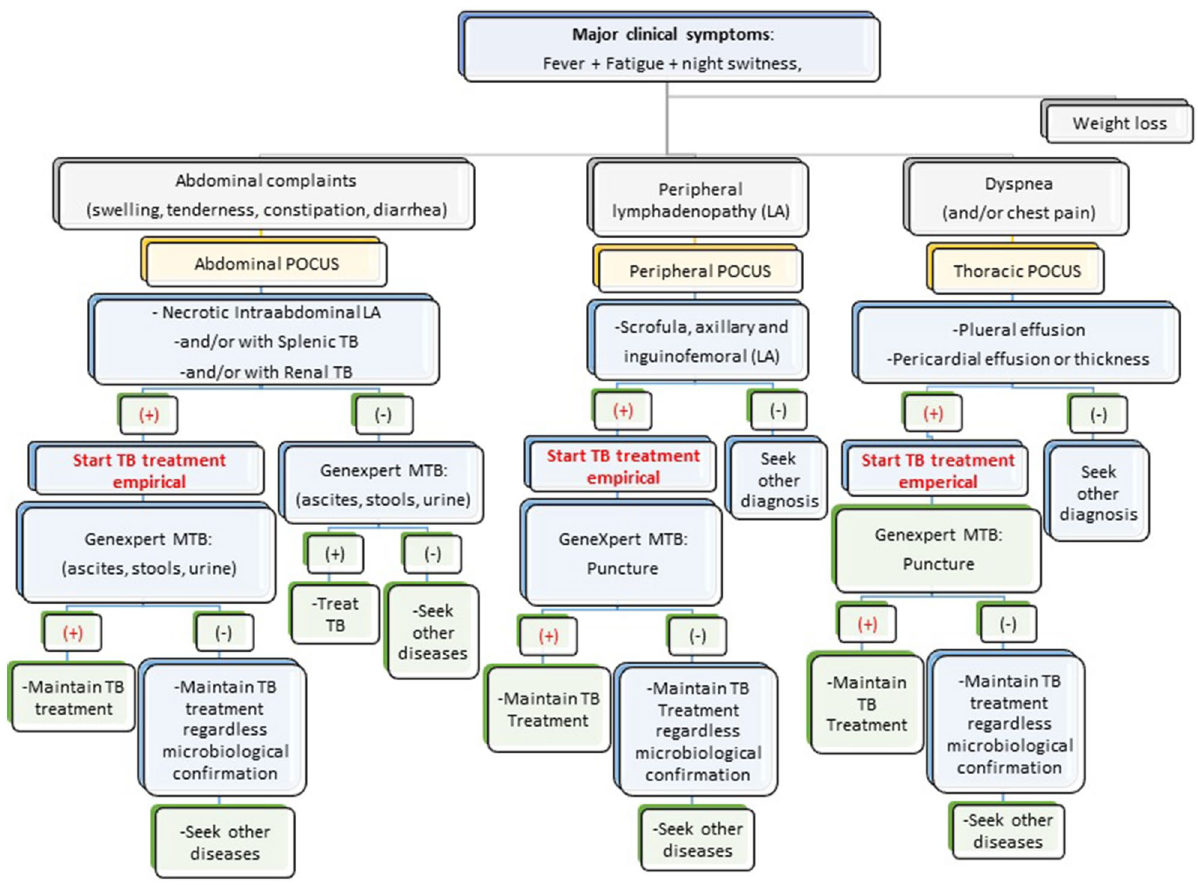
Figure 2. Point-of-Care Ultrasound (POCUS) algorithm adjusted to Carmelo Hospital of Chokwe for the management of extrapulmonary